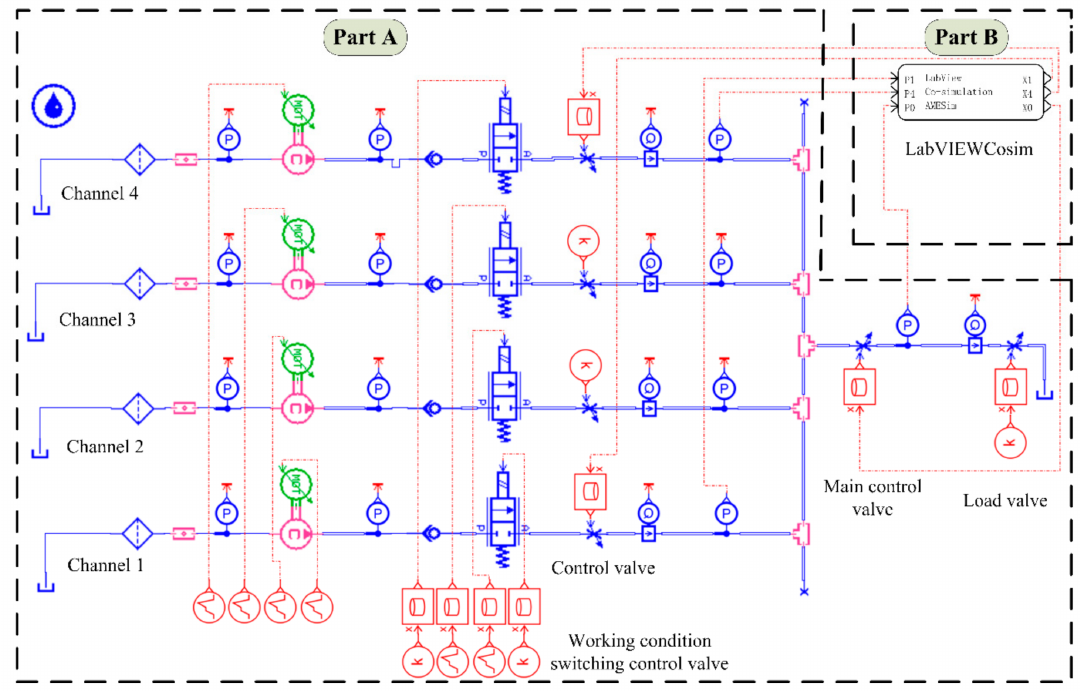
Figure 5. Sketch of the AMESim simulation model: Part A is the AMESim simulation model of MCCS; Part B is interface module of the co-simulation platform.